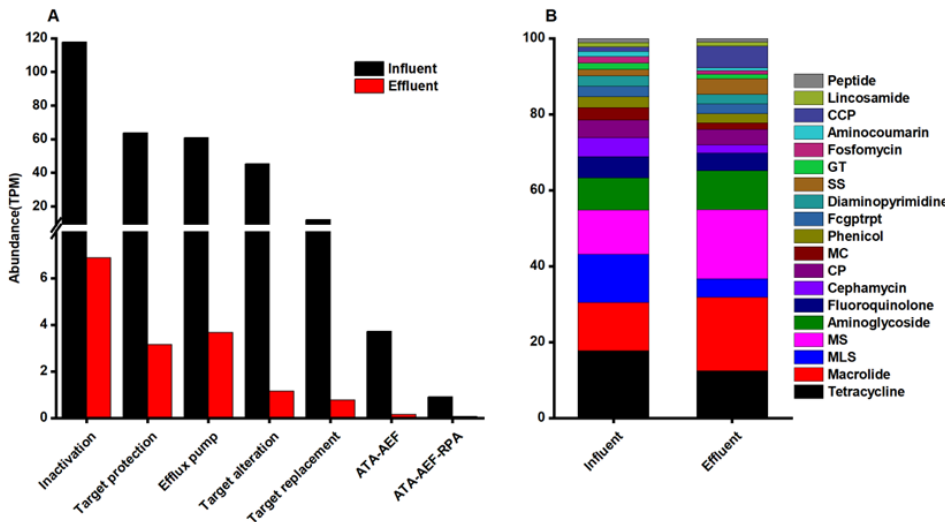
Figure 5. Abundance of antibiotic resistance genes, visualized by Origin 2022. ( A ) Abundance of ARGs classified by resistance mechanism in influent and effluent samples. ATA-AEF: antibiotic target alteration-antibiotic efflux; ATA-AEF-RPA: antibiotic target alteration-antibiotic efflux-reduced permeability to antibiotic; ( B ) Percent abundance (relative abundance > 1%) of influent and effluent samples classified by Drug Class in samples. MLS, MS, CP, MC, Fcgptrpt, SS, GT and CCP represent multi-resistance categories, as shown in Abbreviation.